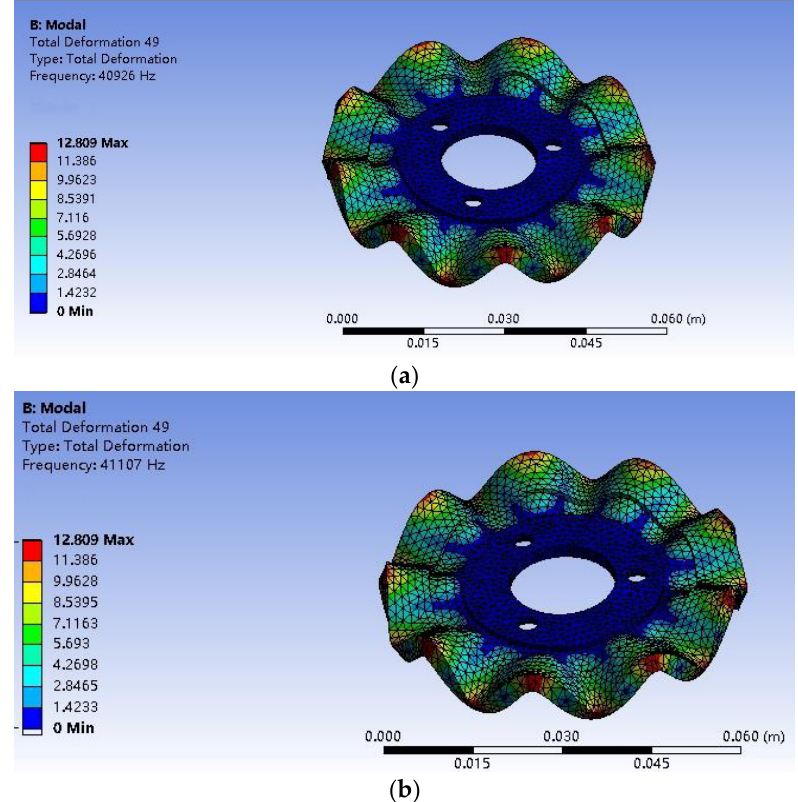
Figure 9. Stator modal frequency. ( a ) B 09 mode frequency with a preload of 0 N. ( b ) B 09 mode frequency with a preload of 50 N.